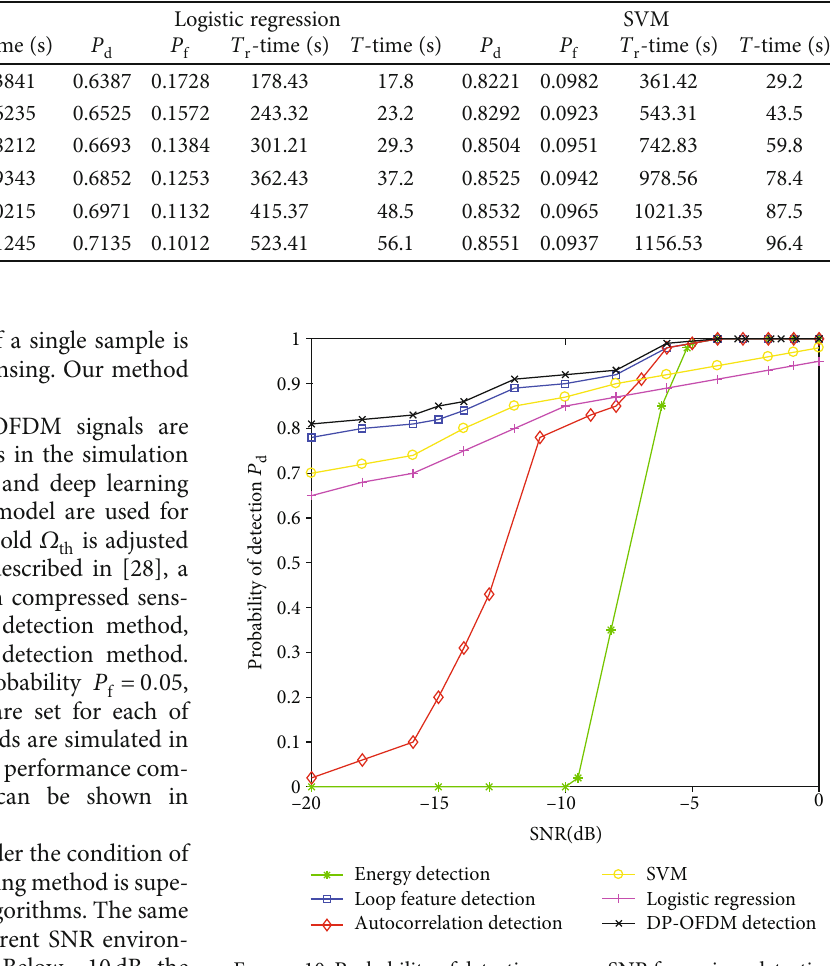
Figure 10: Probability of detection versus SNR for various detection algorithms P = 0 : 05 f